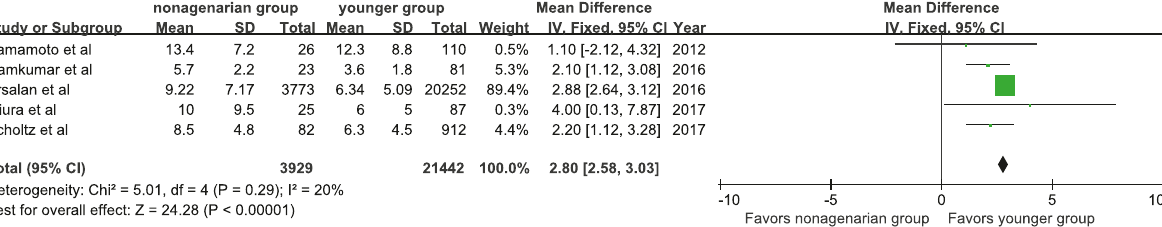
Figure 2: Forest plot of pooled analysis comparing Society of Thoracic Surgeons score of nonagenarians versus younger patients.